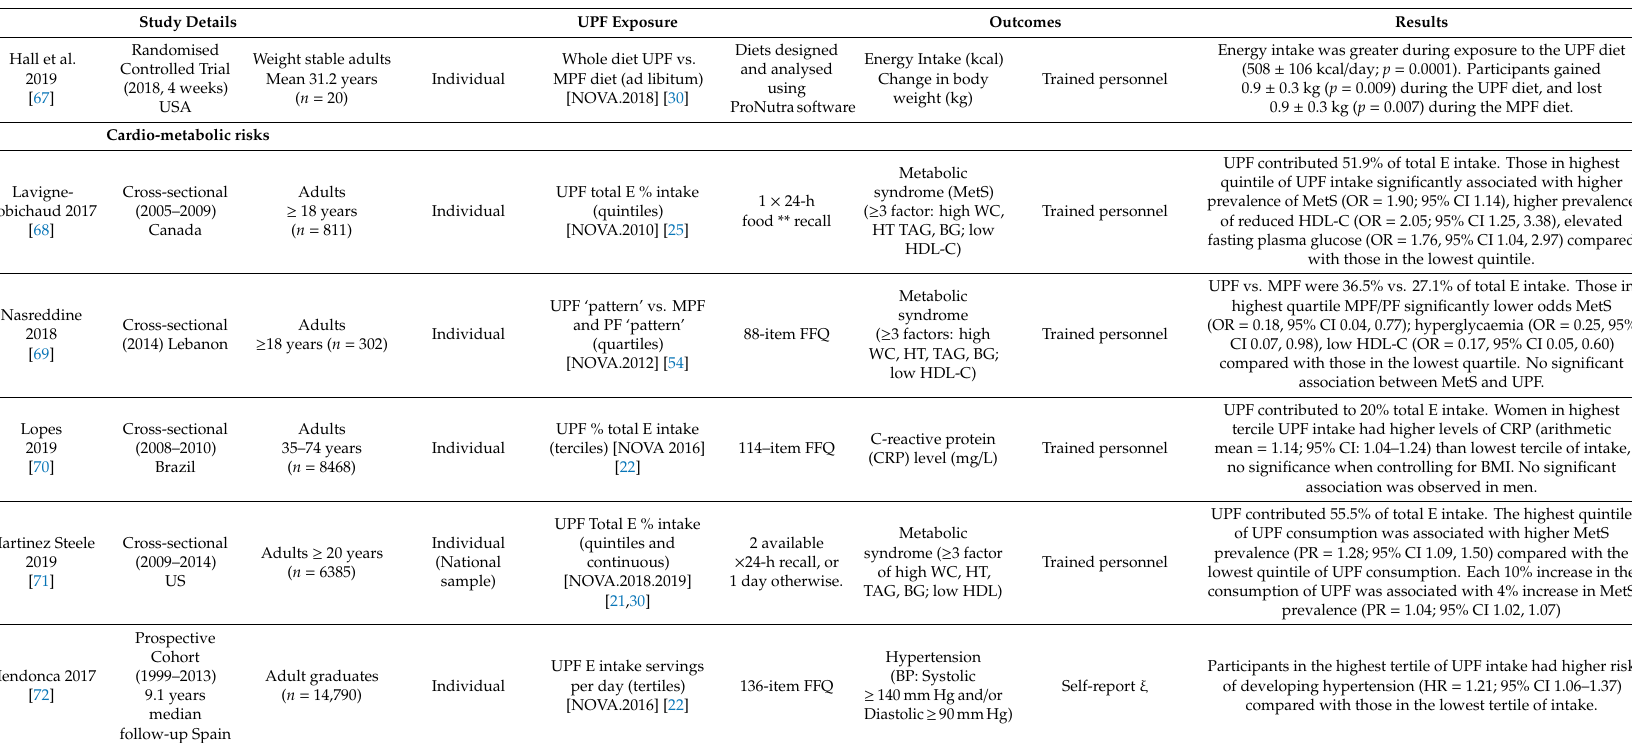
Table 3; UPF: ultra-processed food (includes foods and beverages); BOA: Board of Agriculture; BMI: Body Mass Index [weight (kilograms) / height (metres) 2 ]; E: energy in kilocalories or kilojoules; WHO: World Health Organisation; OR: odds ratio; CI: confidence interval; WC: waist circumference (cm); increased WC: (men ≥ 94; women ≥ 80; significantly increased WC (men ≥ 102; women ≥ 88); AO: abdominal obesity (men ≥ 102 cm; women ≥ 88 cm); FFQ: food frequency questionnaire; DGB: Dietary Guidelines for the Brazilian Population; HR: hazards ratio; RR: relative risk; MPF: unprocessed or minimally processed food; MetS: metabolic syndrome; HT: hypertension; TAG: triacylglycerol; BG: blood glucose; HDL-C: high density lipoprotein cholesterol; MPF and PF ‘pattern’: factor derived ‘pattern’ of mainly MPF and processed food (PF); CRP = C-reactive protein; BP = blood